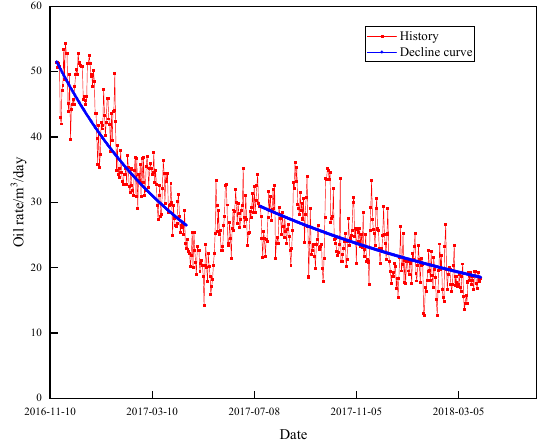
Figure 7. The decline curve analysis.